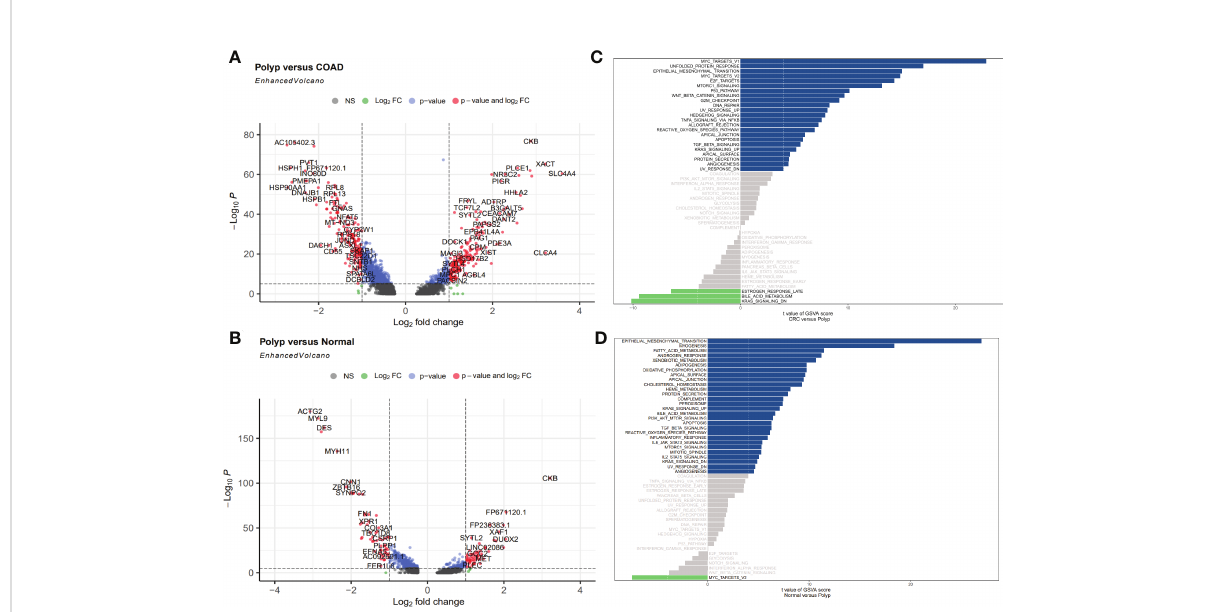
FIGURE 3 (A, B) Volcano plot shows upregulated and downregulated DEGs in enterocytes between different groups. (A) Polyp versus COAD. (B) Polyp versus Normal. (C, D) GSVA was used to determine the differences in pathways enriched per cell in enterocytes isolated from different samples. (C) Polyp versus COAD. (D) Polyp versus